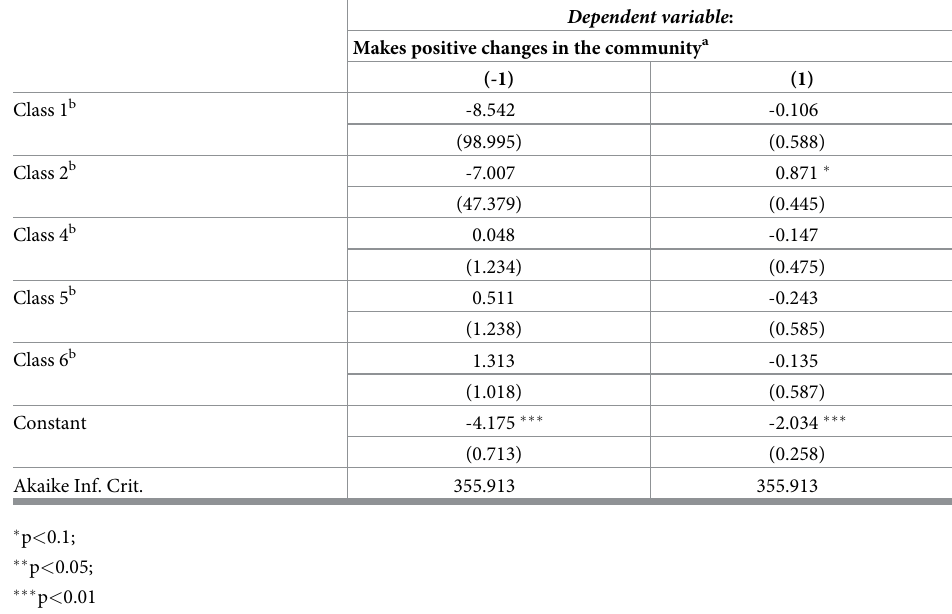
Table 5. Multinomial results illustration (A4: Makes positive changes in the